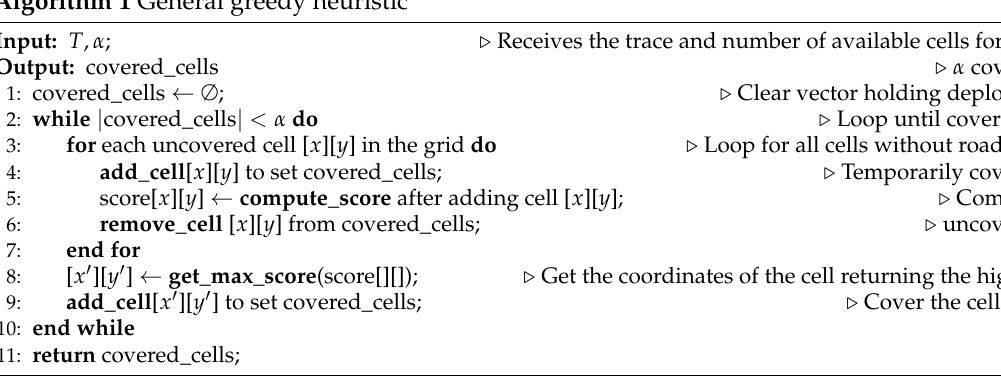
Algorithm 1 General greedy